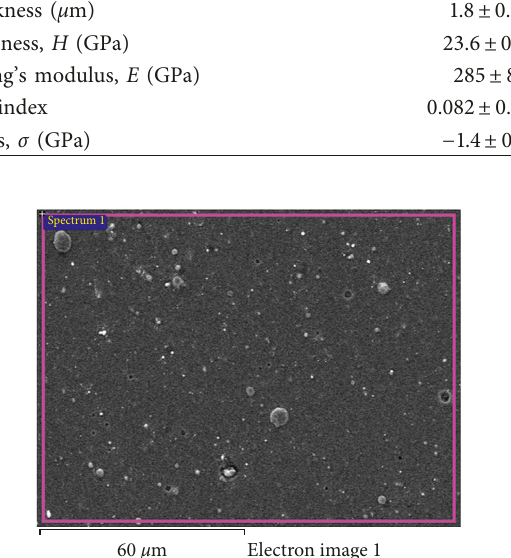
Figure 9: SEM image of CrN coating surface in EDS analysis.